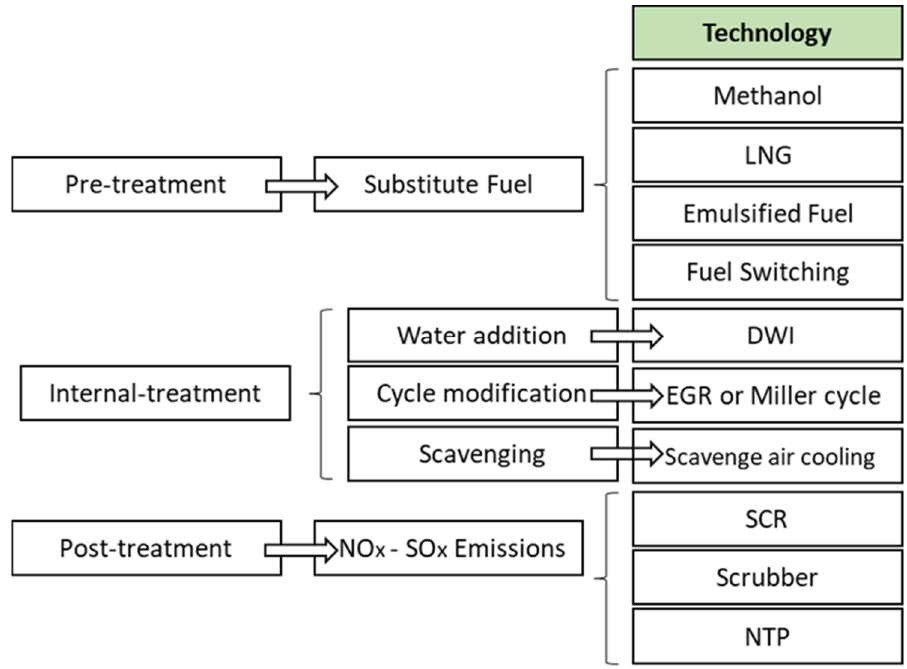
Figure 17. Pre-treatment, internal-treatment, and post-treatment options for lowering SOx and NOx Figure 17. Pre ‐ treatment, internal ‐ treatment, and post ‐ treatment options for lowering SOx and NOx emissions from marine diesel engines. emissions from marine diesel